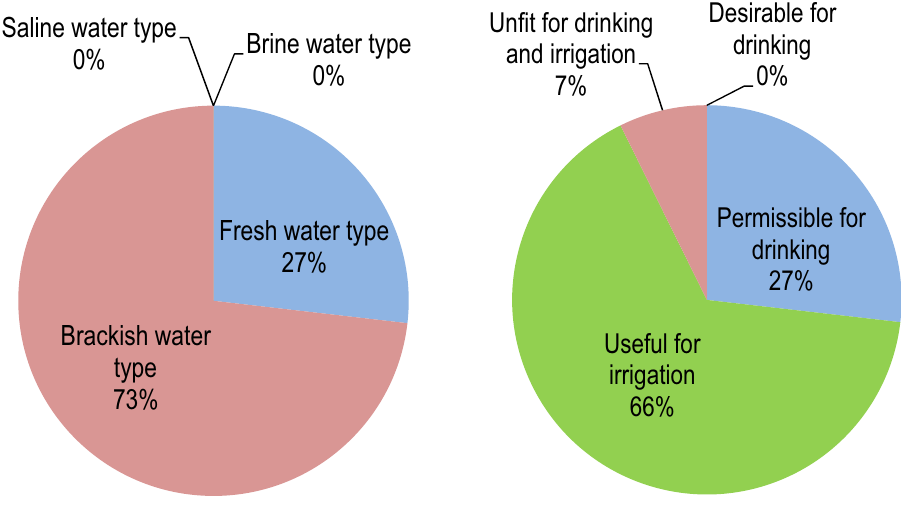
Fig. 8 Classification of ground- water samples based on TDS. Left based on Freeze and Cher- rey (1979) and right based on Davis and DeWiest